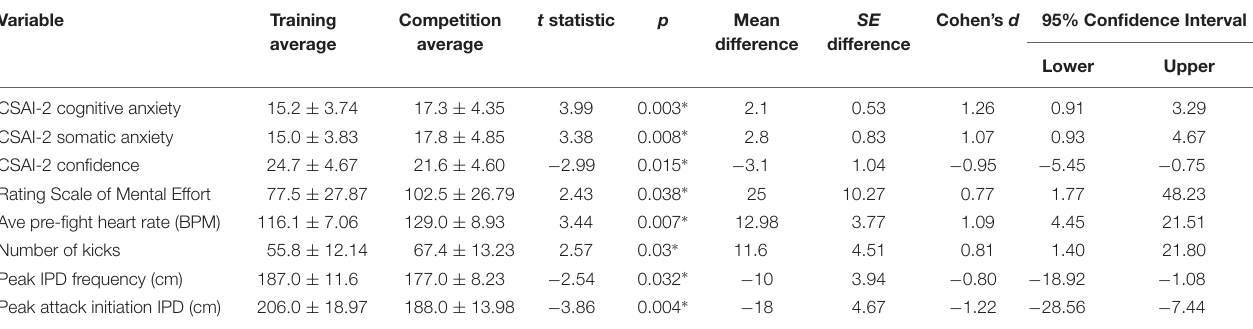
TABLE 3 | Results summary of perceived anxiety, arousal and perceived mental effort.